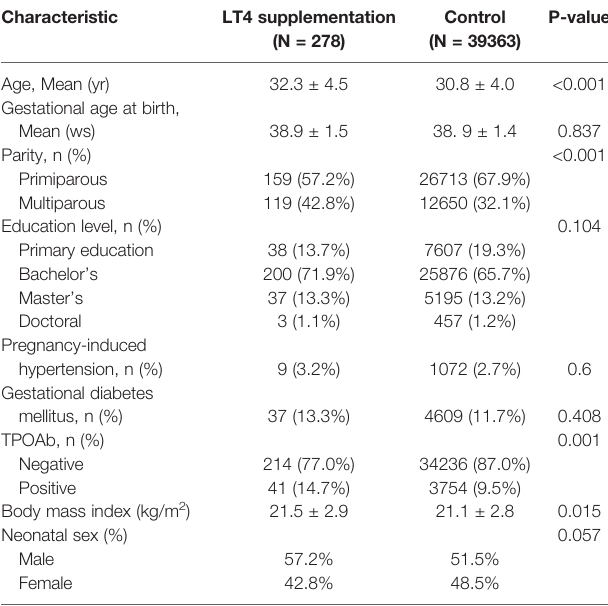
TABLE 1 | Baseline characteristics of the study